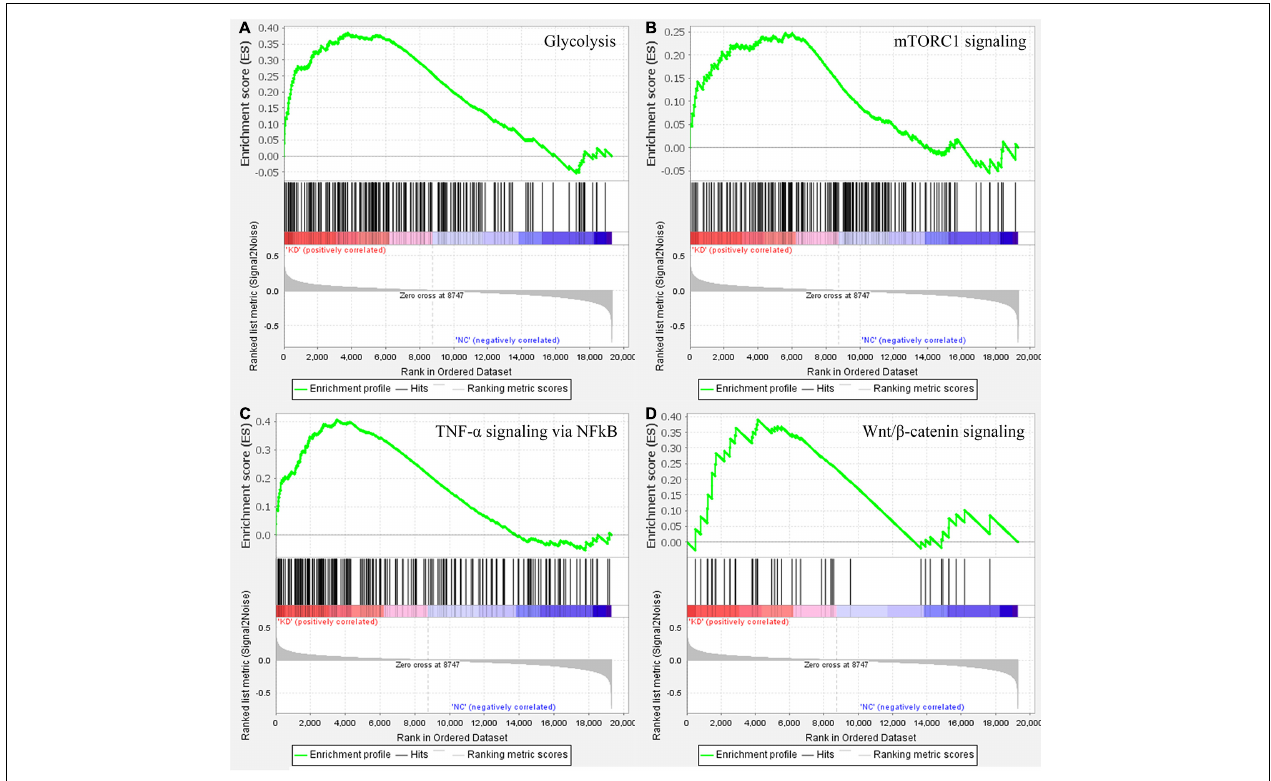
FIGURE 5 | Gene set enrichment analysis on the cervical samples with WASL knockdown. (A) glycolysis, (B) TNF-a signaling via NF-kB, (C) mTORC1 signaling, (D) Wnt/b-catenin signaling.